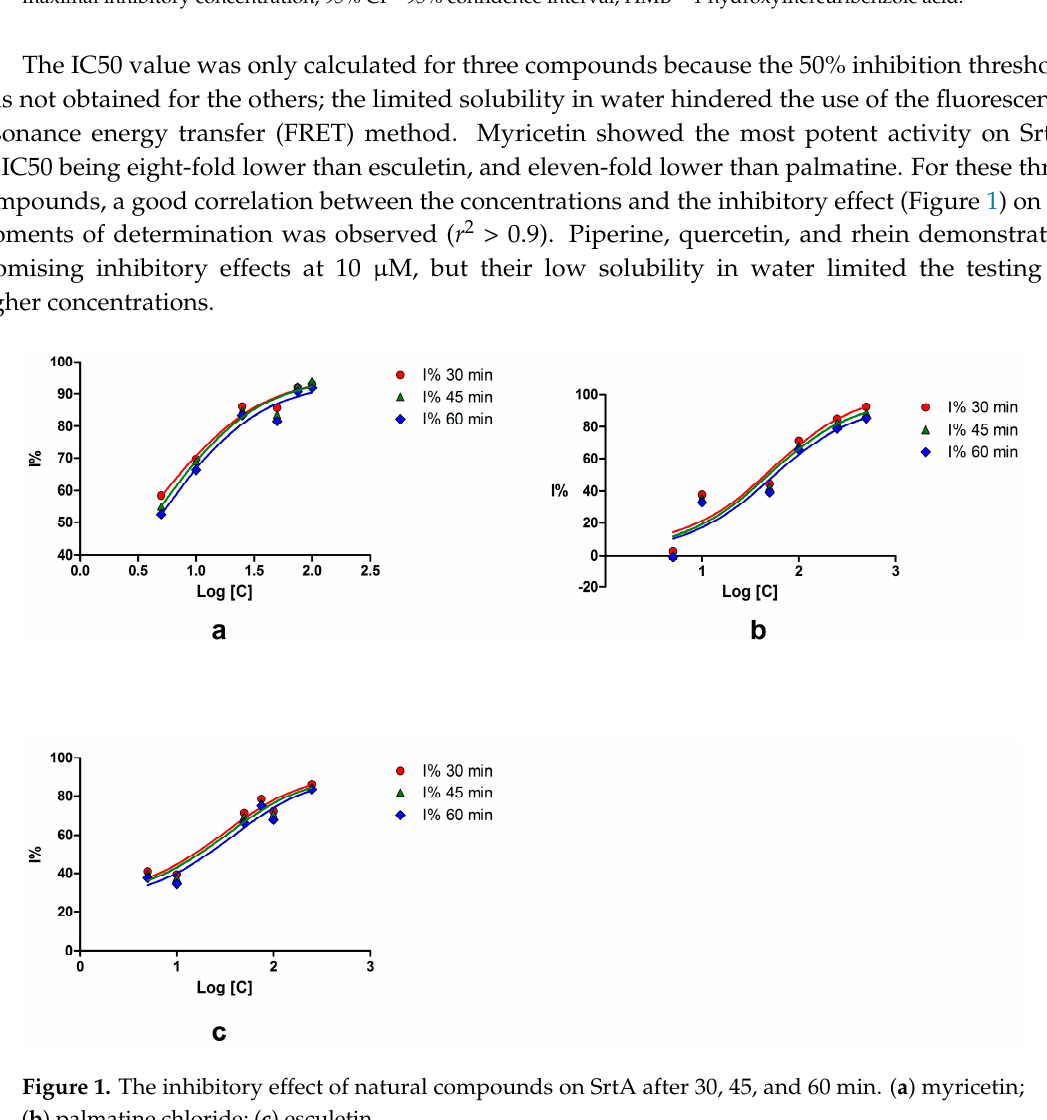
Table 1. The inhibitory effect on SrtA after 1 h of incubation.